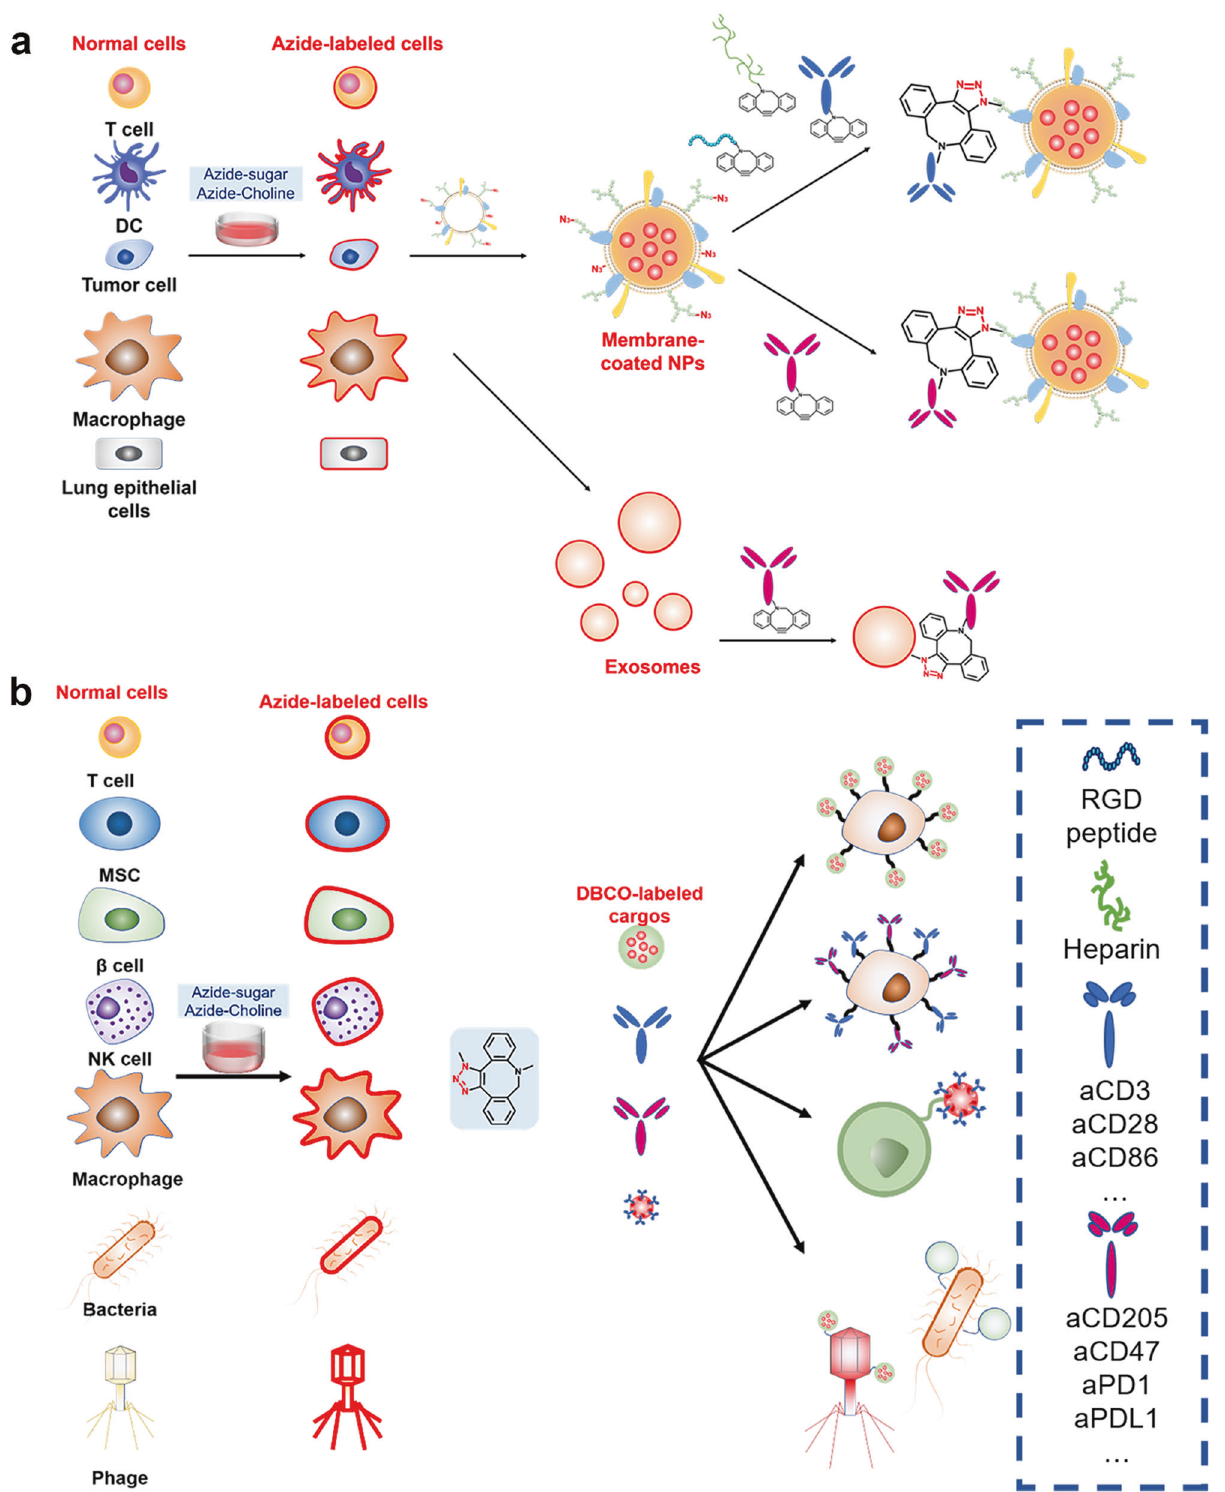
Fig. 6 Application of bioorthogonal chemistry in developing bio-inspired DDSs. a Constructing biomimetic DDSs by bioorthogonal chemistry. Targeting and immunoregulating molecules can be modi fi ed onto cell membranes to construct multi-functional biomimetic DDSs. b DBCO- modi fi ed nanoparticles, antibodies, and platelets can be conjugated onto cell membranes or the surface of bacteria and phages to construct functionalized cell-based, bacteria-based and phage-based DDSs